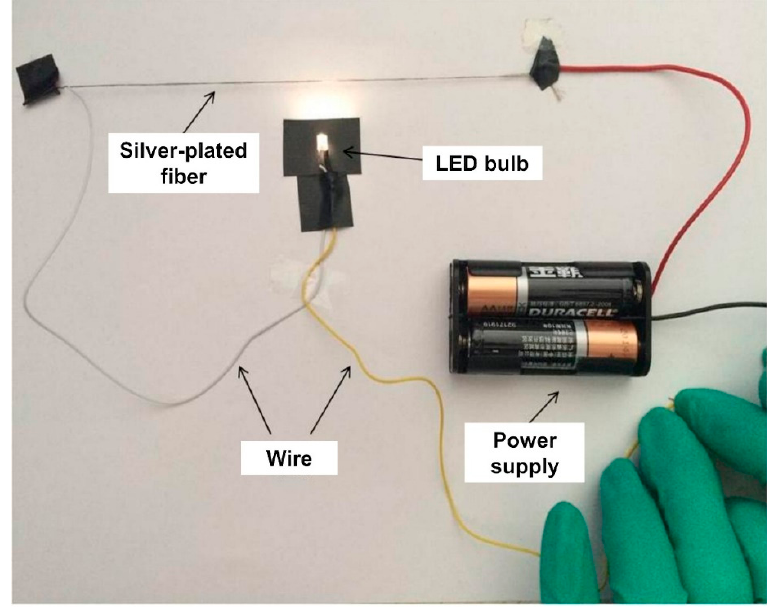
Figure 11. The luminescence experiment of a small bulb.